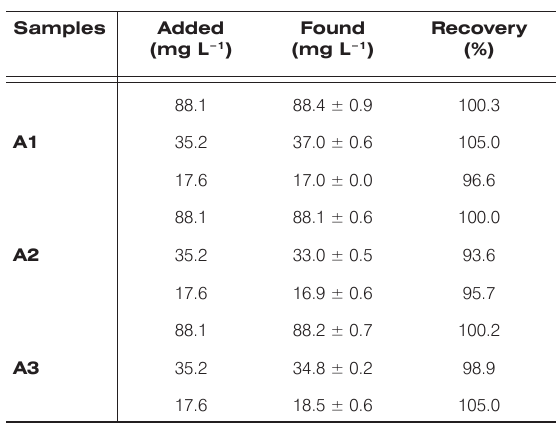
Table 1. Recovery from AA pharmaceutical